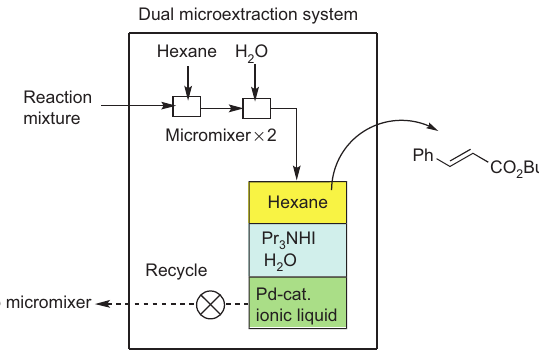
Scheme 8 Workup system based on dual flow microextraction system.